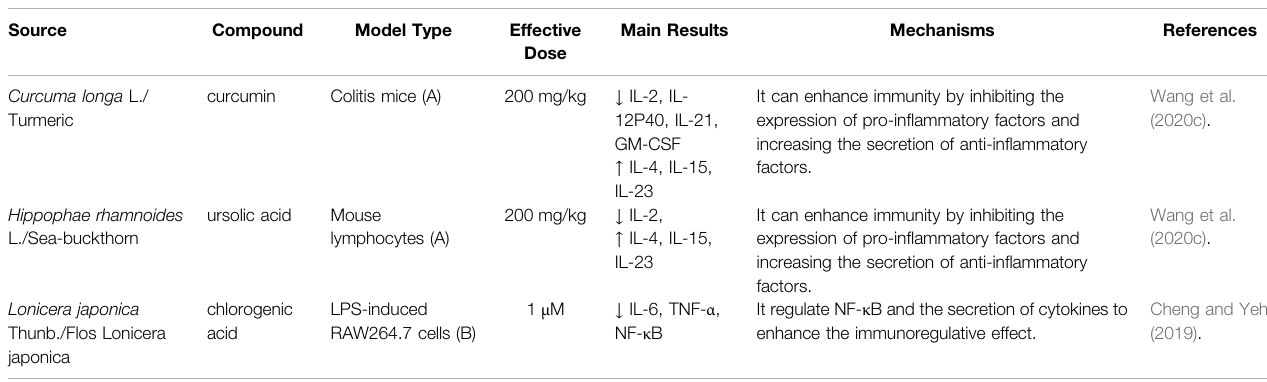
TABLE 4 | Other components in plant-based functional foods on immune